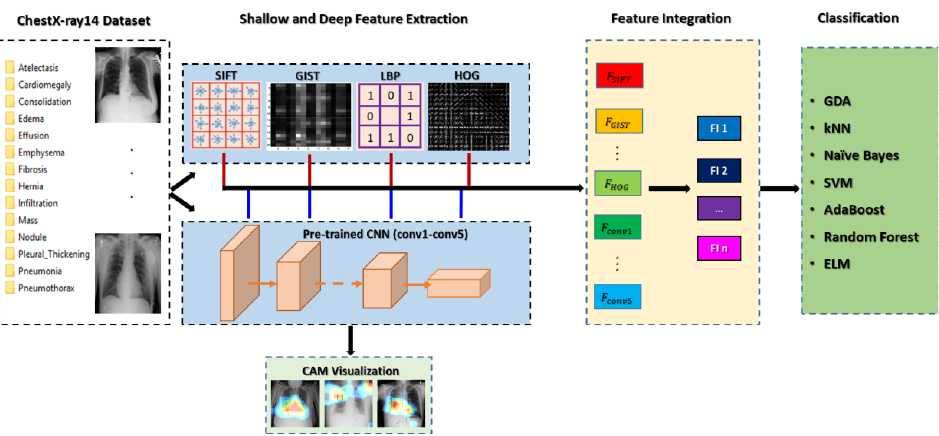
Figure 1. Framework of the proposed multiple feature integration approach.